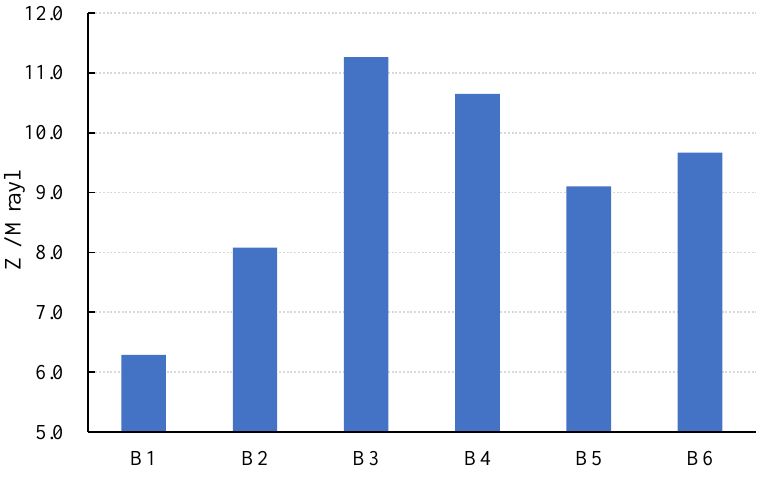
Figure 14. Changes in Z of specimens with modulus.